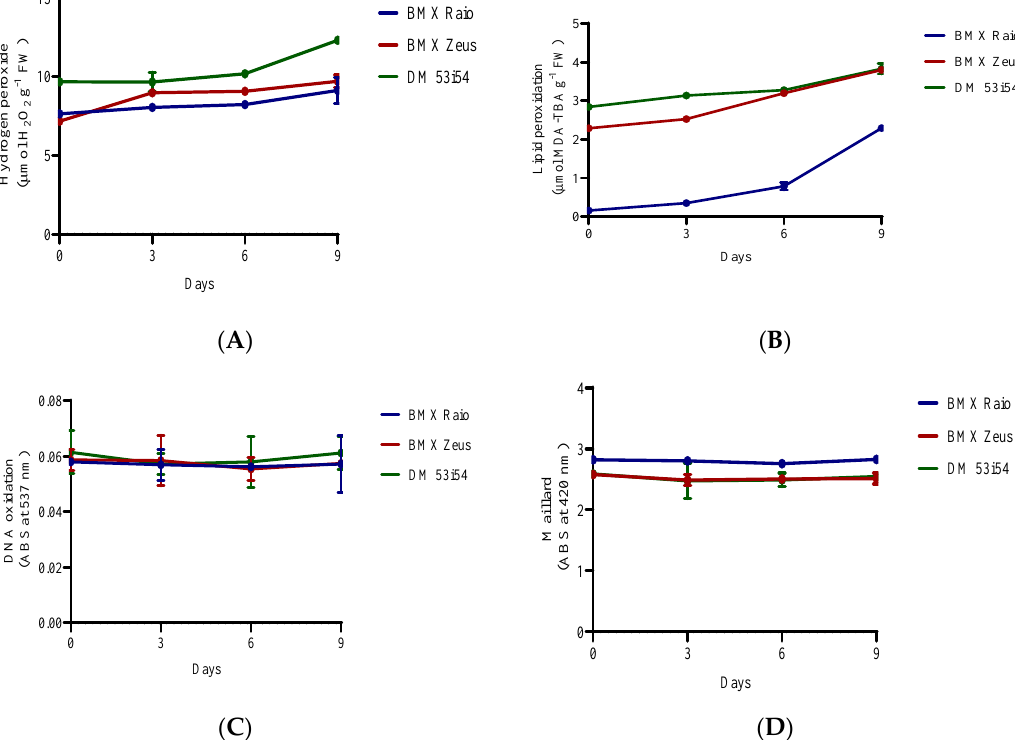
Figure 3. H 2 O 2 ( A ) and malondialdehyde ( B ) content, DNA oxidation ( C ), and Maillard reaction ( D ) of soybean seed axis of three cultivars (BMX Raio, BMX Zeus, and DM 53i54) exposed to different periods of accelerated aging (0, 3, 6, and 9 days).